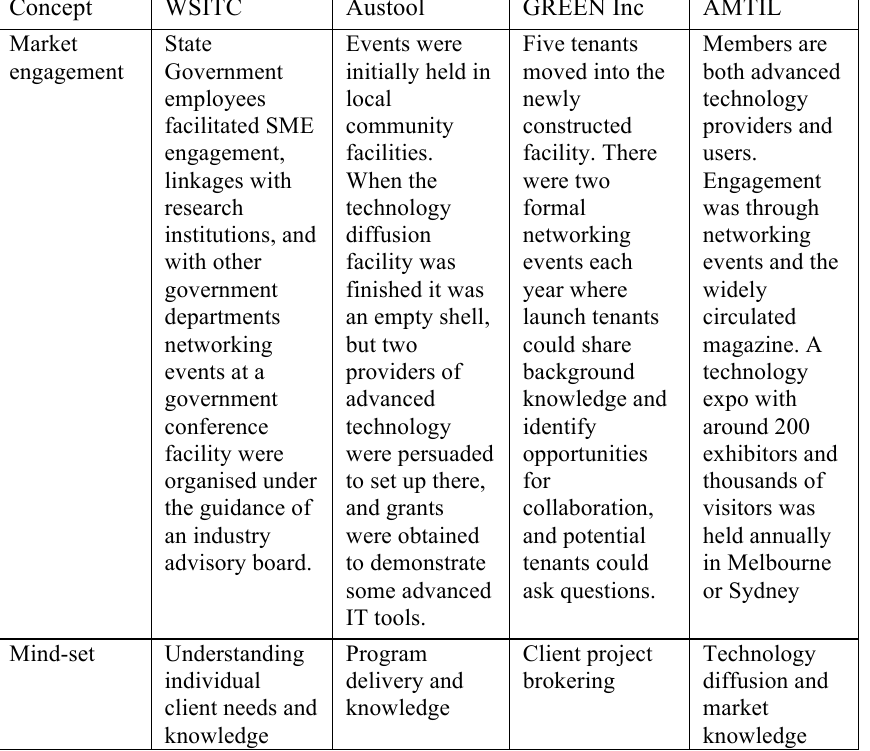
Table 6. Deployment phase concepts